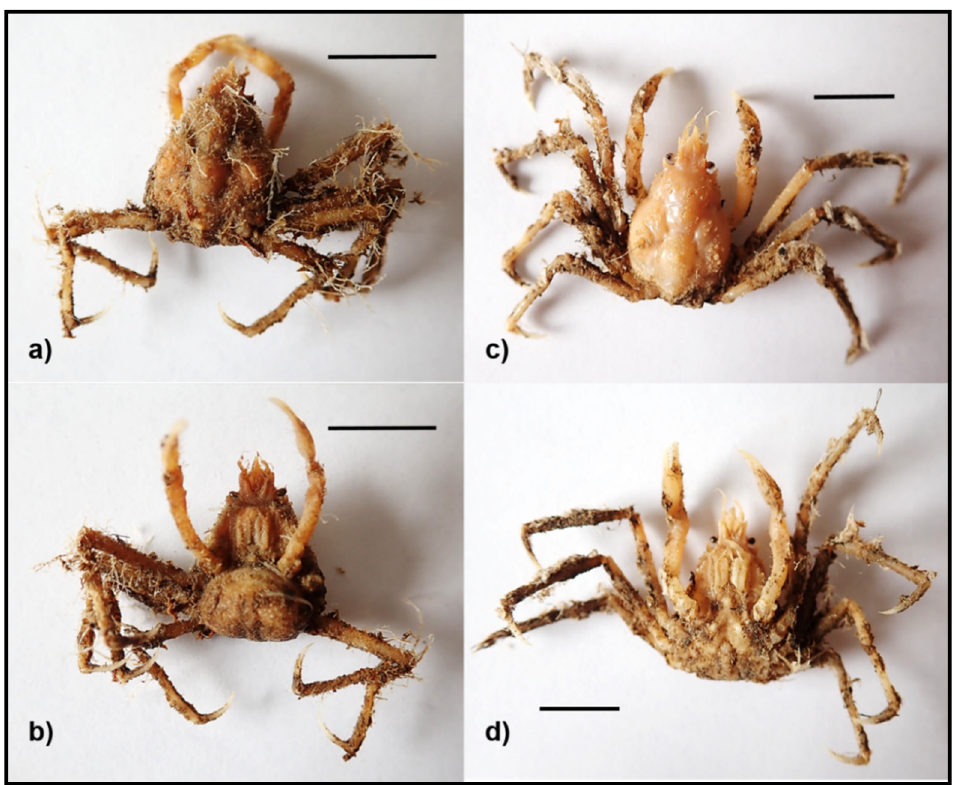
Figure 2. Pyromaia tuberculata collected in the Tagus estuary, Portugal. Female (Pt2) dorsal ( a ) and ventral ( b ) views; male (Pt3) dorsal ( c ) and ventral ( d ) views. Scale bar represents 10